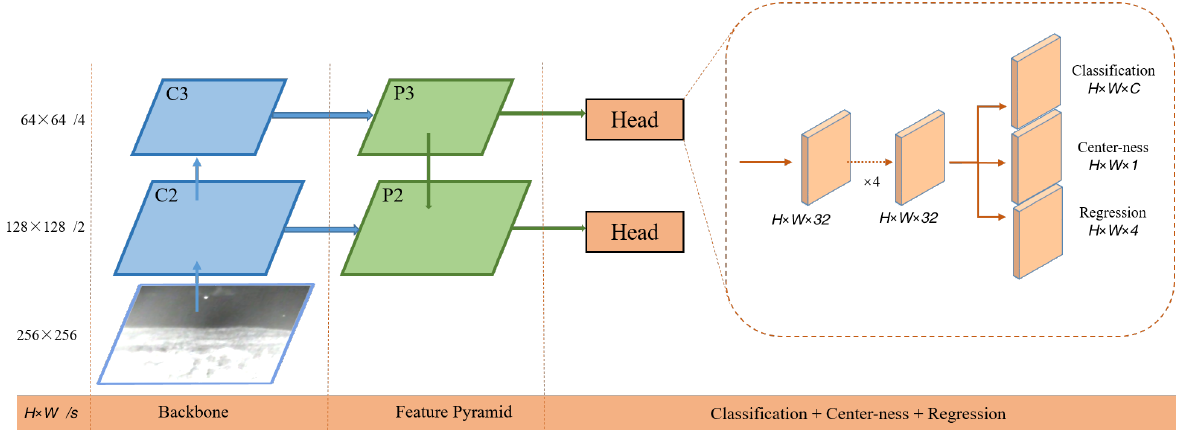
Figure 4. Improved FCOS network